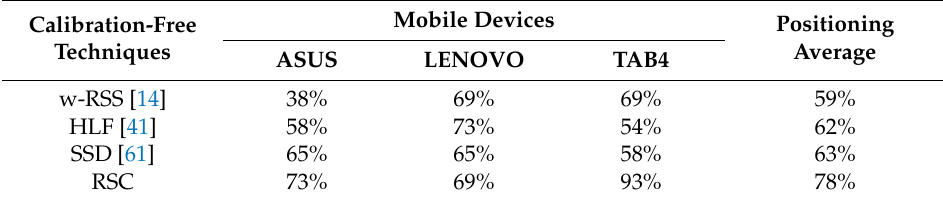
Table 3. Positioning results based on different calibration-free